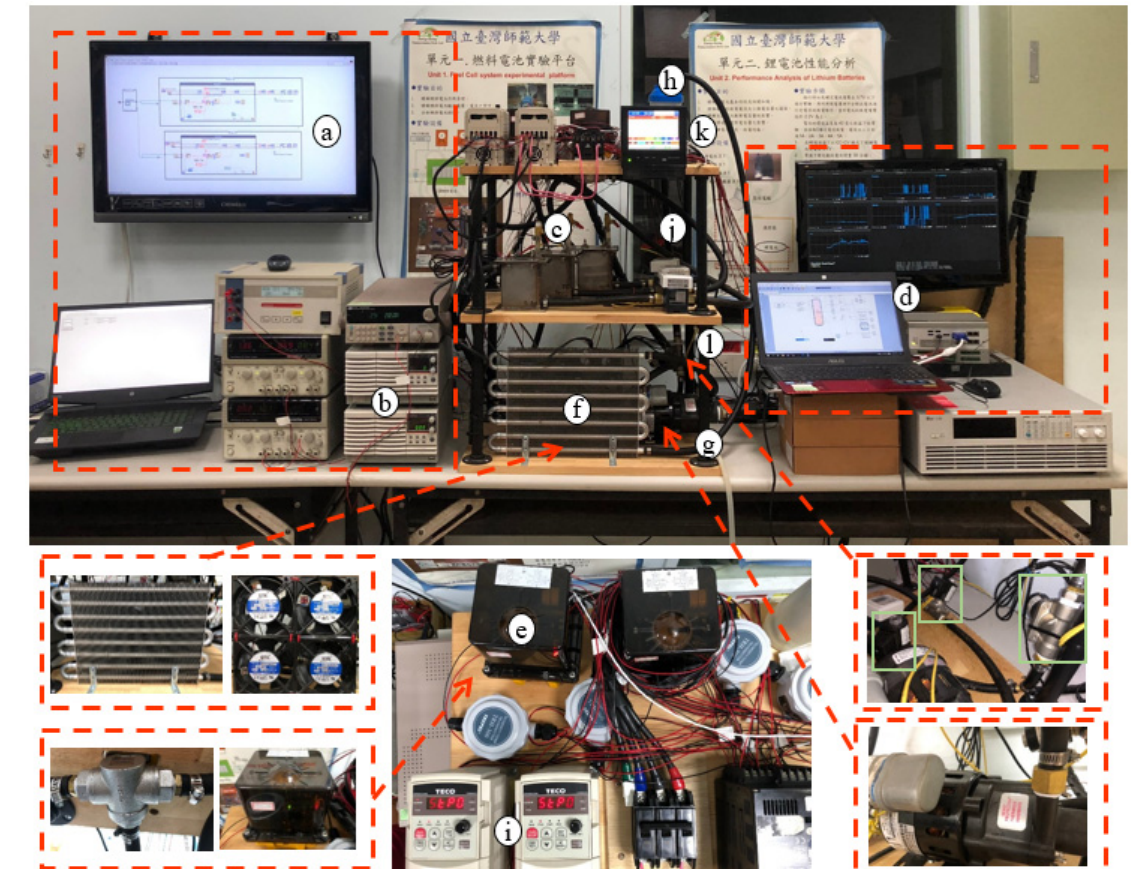
Figure 6. Experimental platform of the IHTMS.